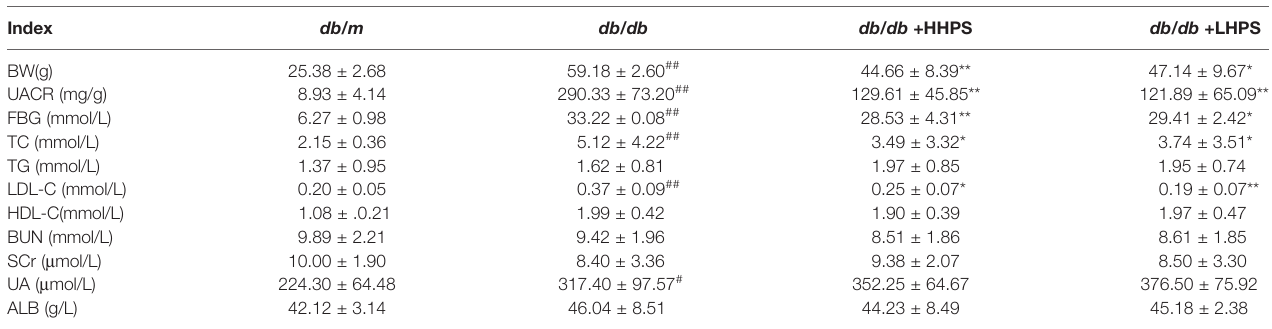
TABLE 3 | The effects of Hyperoside pre-treatment on clinical and metabolic parameters of db/db mice. Index